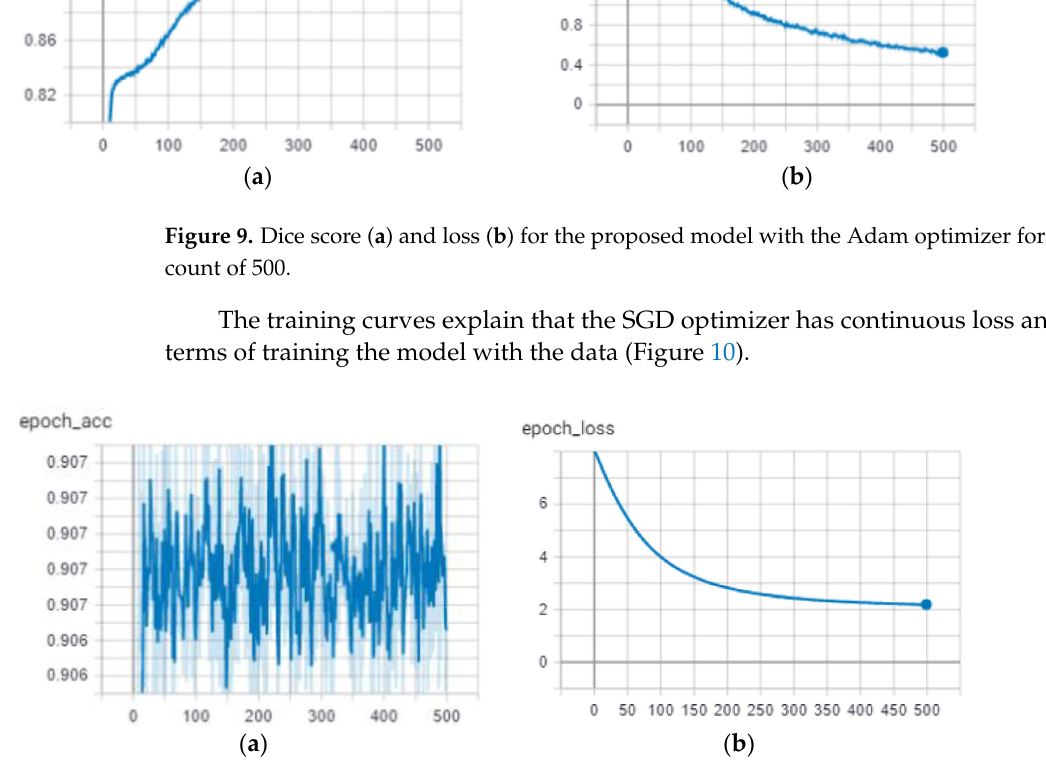
Figure 10. Accuracy ( a ) and loss ( b ) of the SGD optimizer for the proposed model for the epoch count of 500.